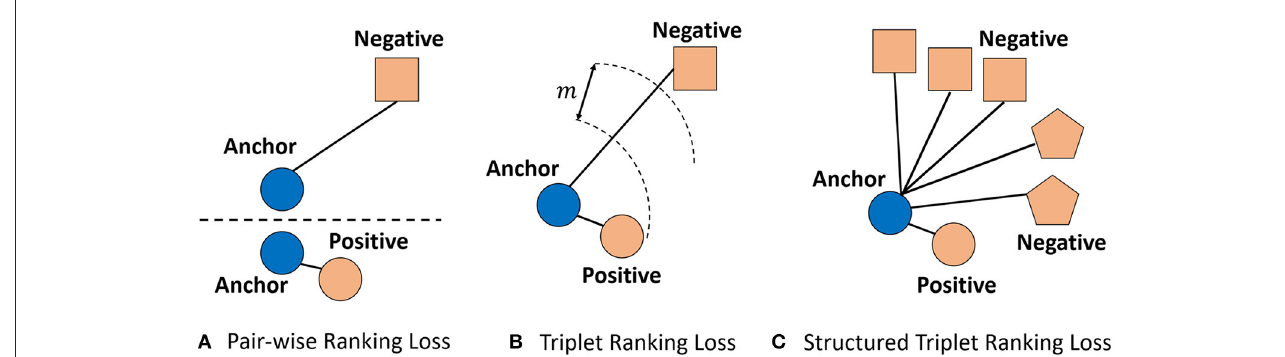
FIGURE4 Illustration of the (A) Pair-wise Ranking loss, (B) Triplet Ranking loss, and (C) Structured Triplet Ranking loss. Different shapes represent different classes. The blue circle is an anchor. For Pair-wise Ranking loss, the anchor and one positive example or one negative example are considered for every loss computation. For Triplet Ranking loss, the anchor is compared with only one negative example and one positive example. For the Structured Triplet Ranking loss, the anchor is compared with all negative examples.